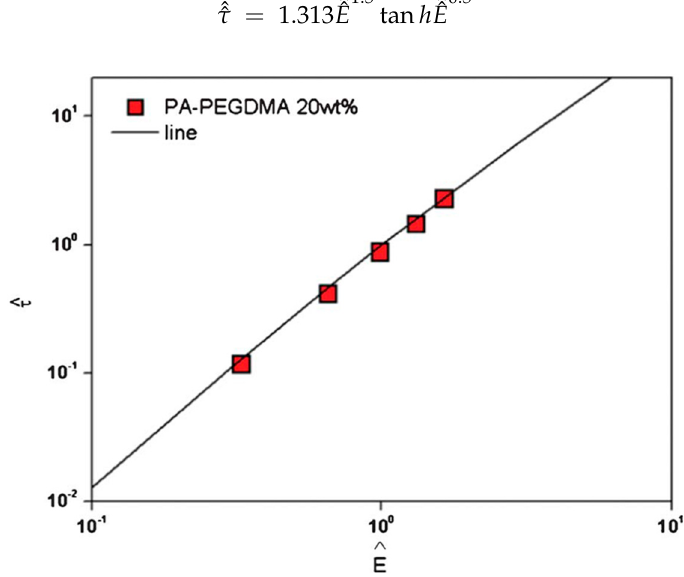
Figure 14. (cid:2028)̂ versus (cid:1831)(cid:3552) for PMMA/PANI-based ER fluids. The solid line was drawn using Equation Figure 14. ˆ τ versus ˆ E for PMMA/PANI-based ER fluids. The solid line was drawn using Equation (7). (7). (Fang et al. [122], Copyright The Royal Society of Chemistry, 2011). (Fang et al. [122], Copyright The Royal Society of Chemistry, 2011).